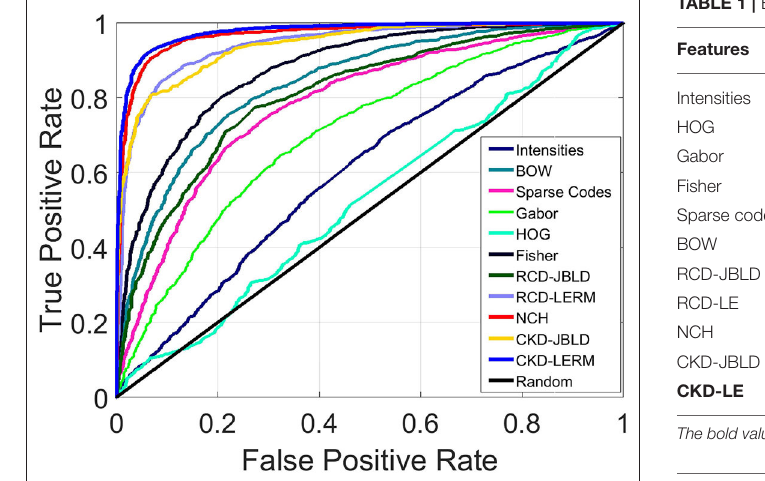
TABLE 1 | Experimental results on FABCD.